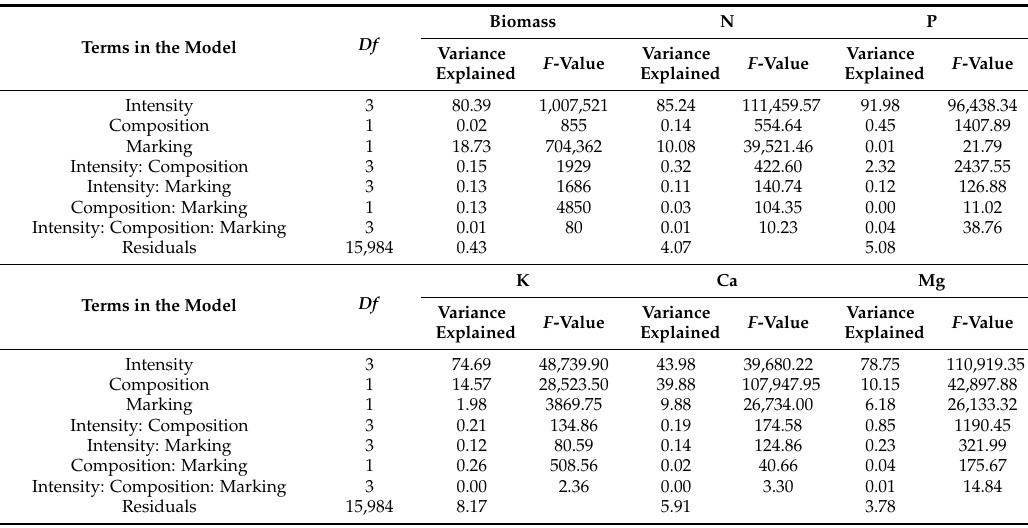
Table 3. Output from the six models applied on nutrient export with biomass harvest from the virtual stands. For each nutrient, the table presents the sum of squares, the proportion of the variance explained (%), and the F value related to each term included in the models. Values in bold indicate the terms selected for graphical exploration that explained more than 1% of the variance. Biomass N P Terms in the Model Df Variance F -Value Variance F -Value Variance F Explained Explained Explained